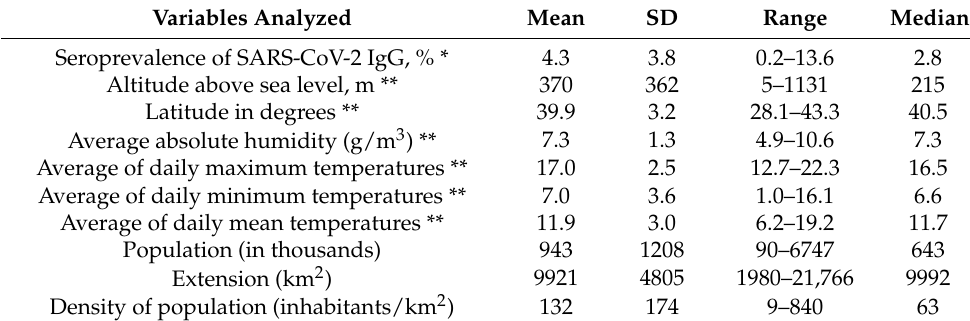
Table 1. Descriptive analysis of the variables considered for the 50 provinces in, Spain.